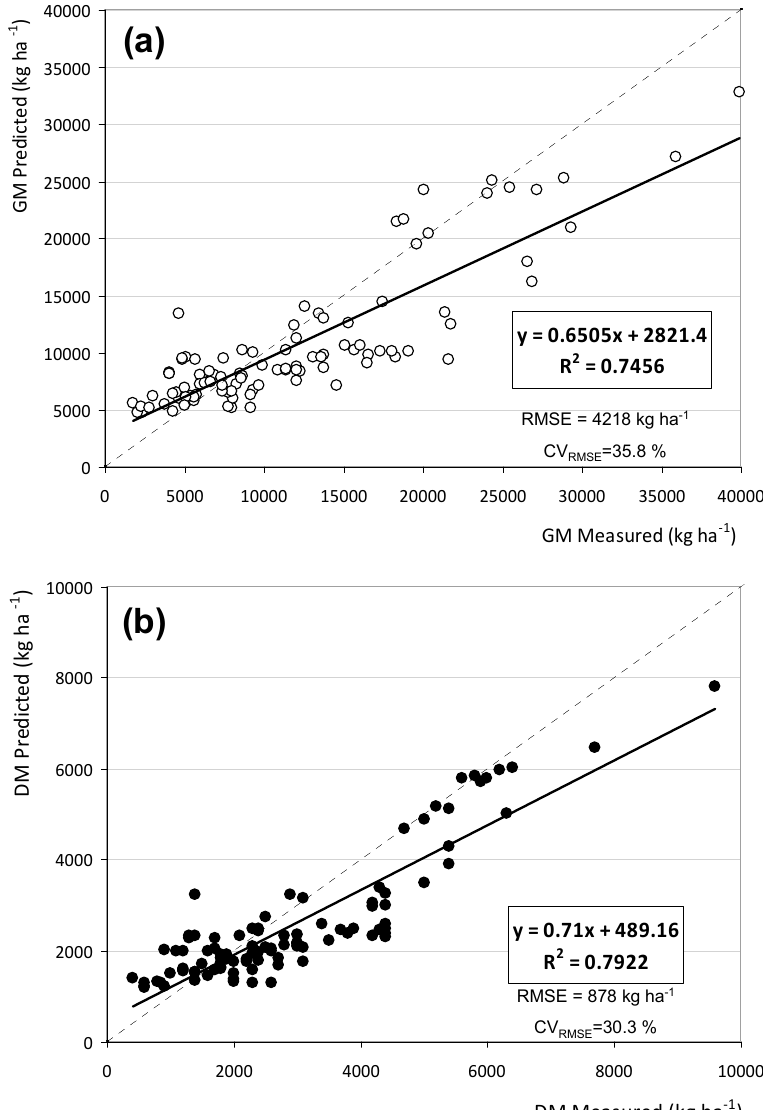
Figure 9. Relation between pasture productivity measured (( a ) green matter; ( b ) dry matter (DM)) in 2019, in eight experimental fields (“Azinhal”, ”Cubillos”, “Grous”, “Mitra B”, “Murteiras”, “Padres”, “Quinta França” and “Tapada”—validation phase), and pasture productivity predicted based on the equations obtained in calibration phase for pasture moisture content (PMC) 70–80%. R 2 —coefficient of determination; RMSE—root mean squared error; CV RMSE —coefficient of variation of root mean squared error.